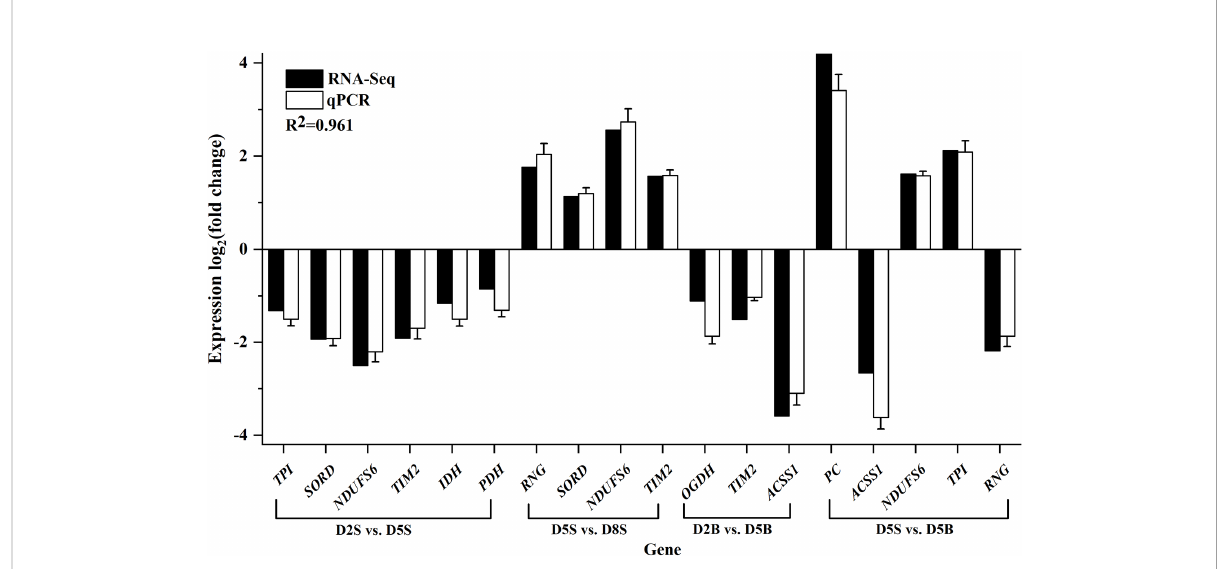
FIGURE 4 RNA-Seq validation using qPCR experiment. 10 DEGs were randomly selected for qPCR experiment. Gene expression patterns were presented as log 2 (fold change) and CYTB was set as the internal reference. D2, D5 and D8 represented the group of 2 ind./tank, 5 ind./tank and 8 ind./ tank, respectively. And the capital letters S and B stand for respiratory trees and body walls tissue of sea cucumber,